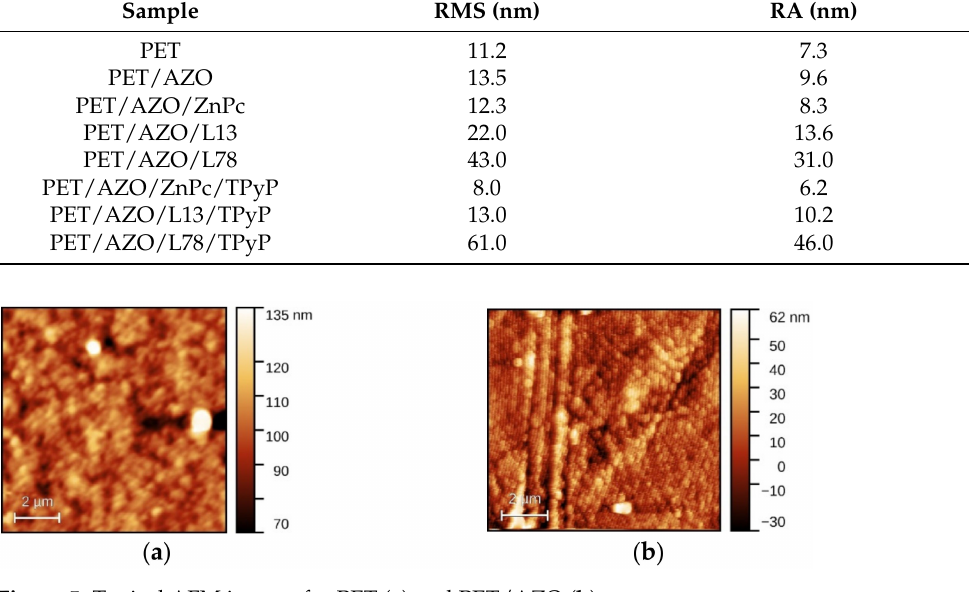
Figure 5. Typical AFM images for PET ( a ) and PET/AZO ( b ).